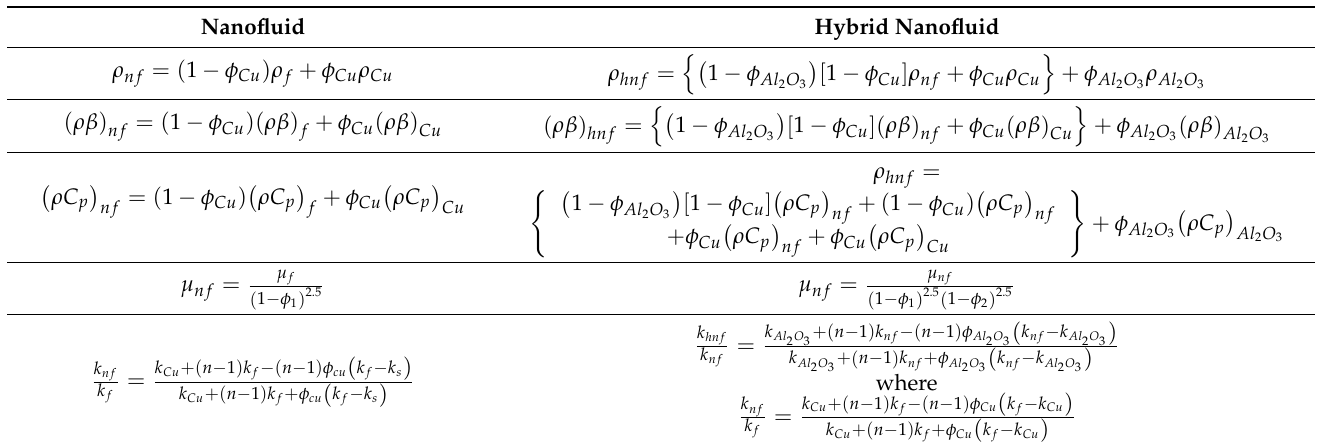
Table 1. Mathematical Models of thermophysical properties.